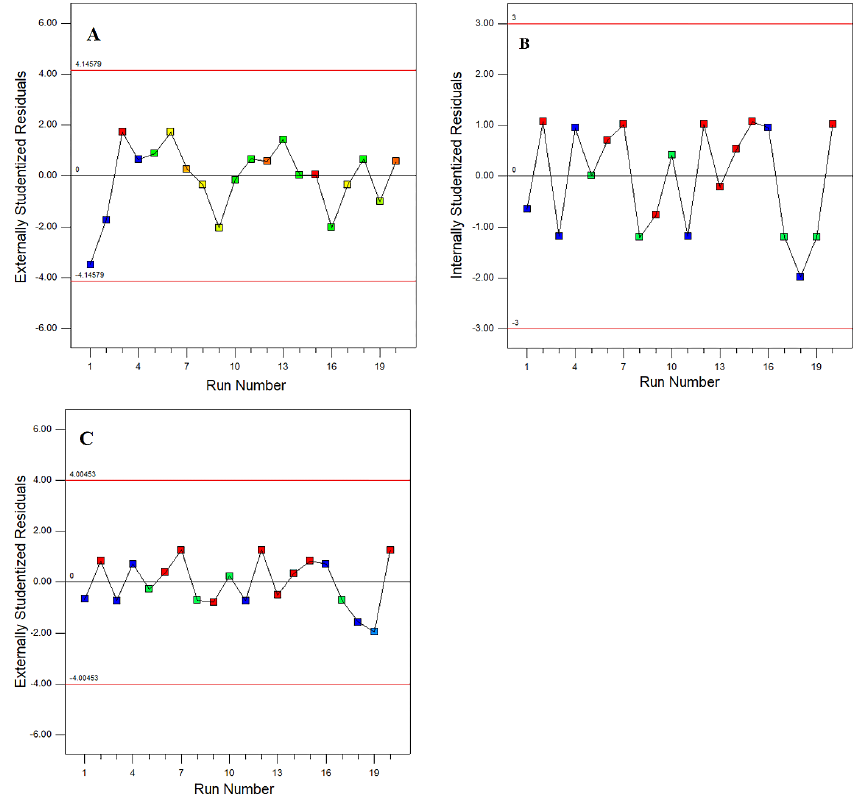
Figure 2. Residual plot of runs from central composite rotatable design for size of the WDM (A), MFC (B), and MIC (C). Note . WDM, well diffusion method; MFC, minimum fungicidal concentration; MIC, minimum inhibitory